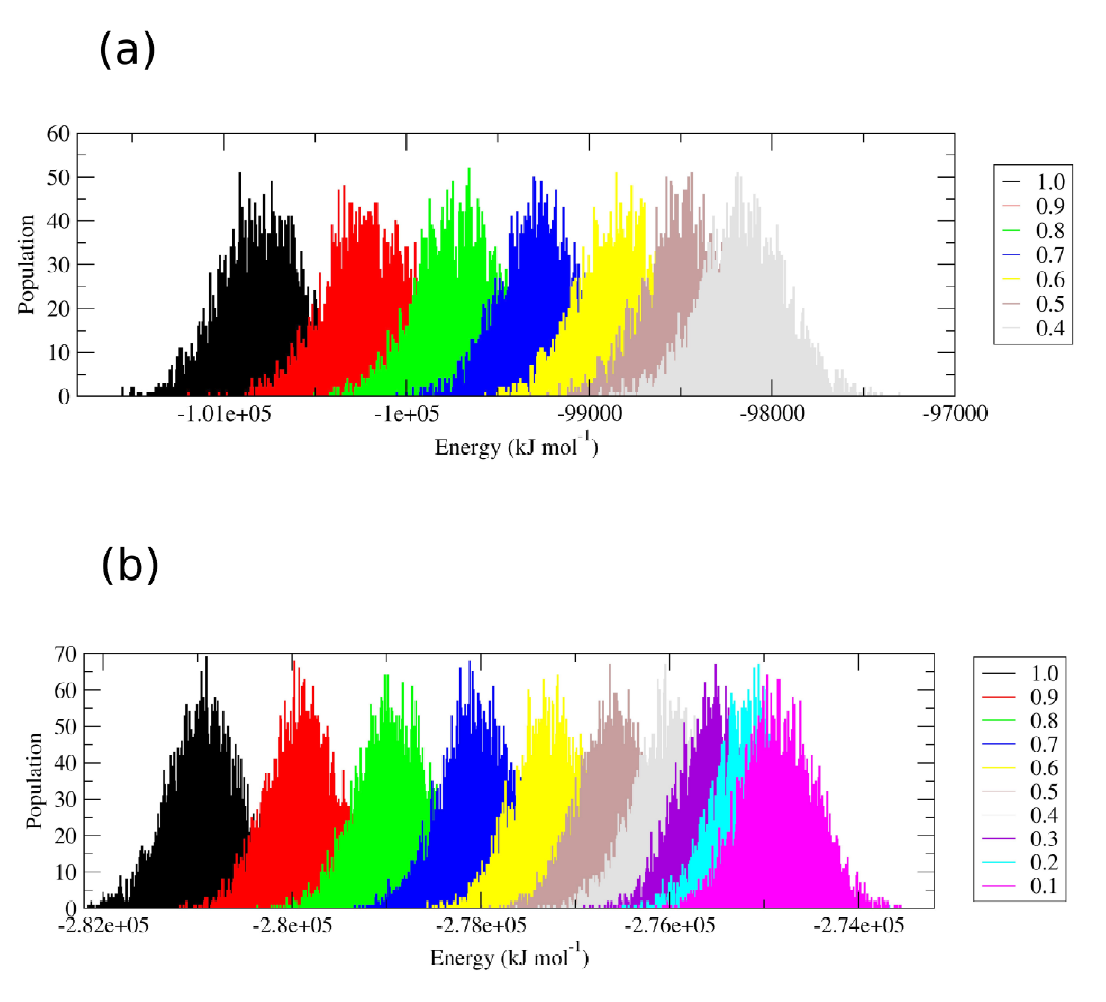
Figure 2. Histograms of the potential energies for the individual replicas, as obtained from the whole Hamiltonian-replica exchange molecular dynamics (H-REMD) simulations for ( a ) HP35 = and ( b ) Protein A. The left-most and right-most curves correspond to the structural ensembles simulated, respectively, with the unmodified and most strongly modified force fields. The curves for neighboring force fields overlap